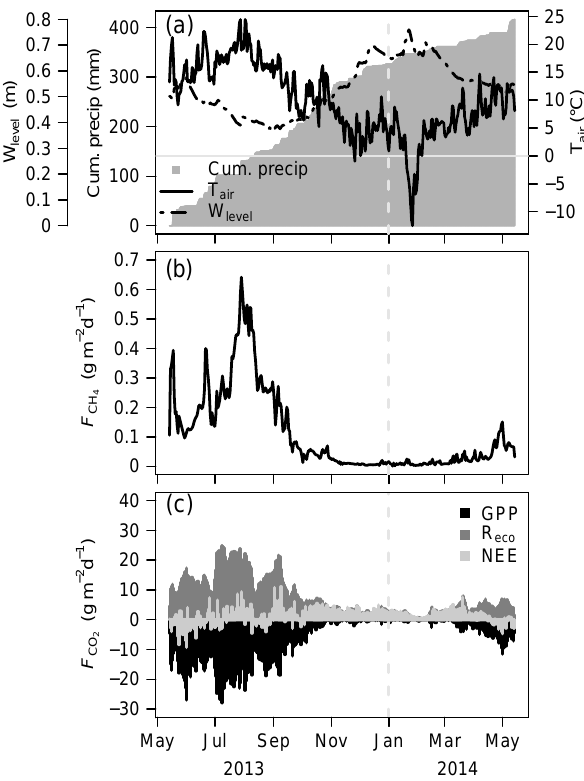
Figure 2. Temporal variability of environmental variables and ecosystem CO 2 and CH 4 exchange within the EC source area. Seasonal course (a) of water level ( W level ), cumulative precip- itation (cum. precip.) and air temperature ( T air ) ; (b) the daily ) ; (c) the daily NEE (gap-filled CH 4 flux (gap-filled NLR CH 4 nofoot ) and component fluxes (modelled R eco and GPP, MDS CO 2 nofoot ) MDS CO 2 nofoot